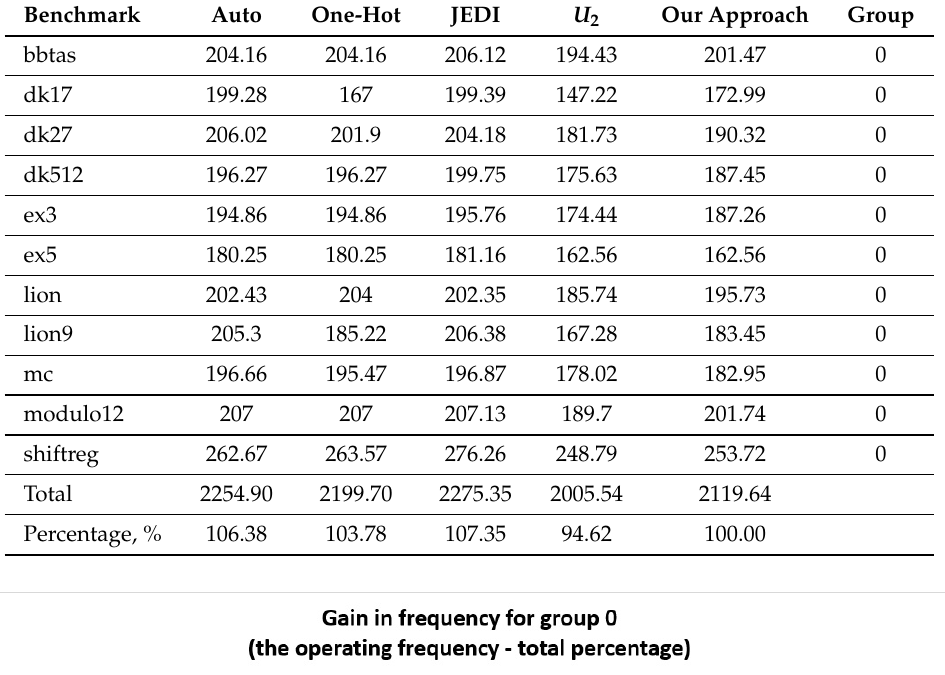
Table 12. Gain in frequency for group 0 (the operating frequency).